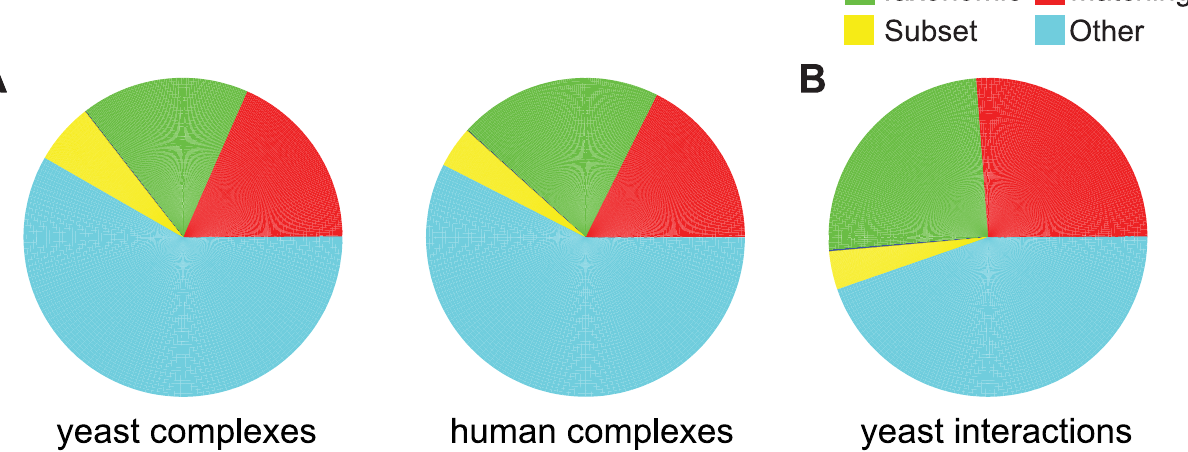
Figure 2. Distribution of the profile relationships of (A) co-complex protein pairs in the two complex data sets and (B) yeast interactions. The 4 differently colored slices correspond to the types of similarities between profiles as described in Methods.